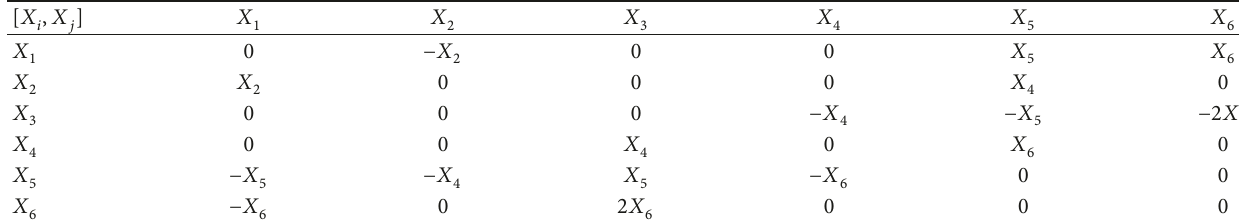
Table 1: Table of Lie